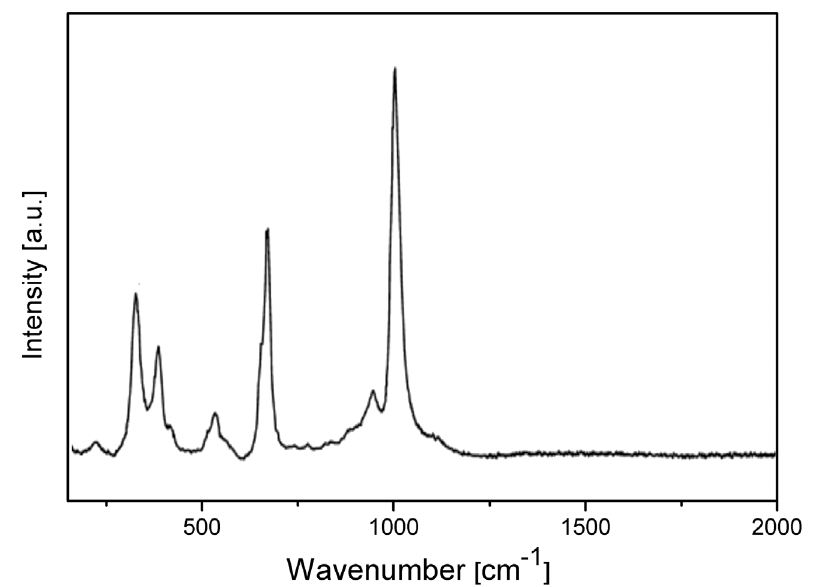
Figure 4: Raman microprobe spectra for natural